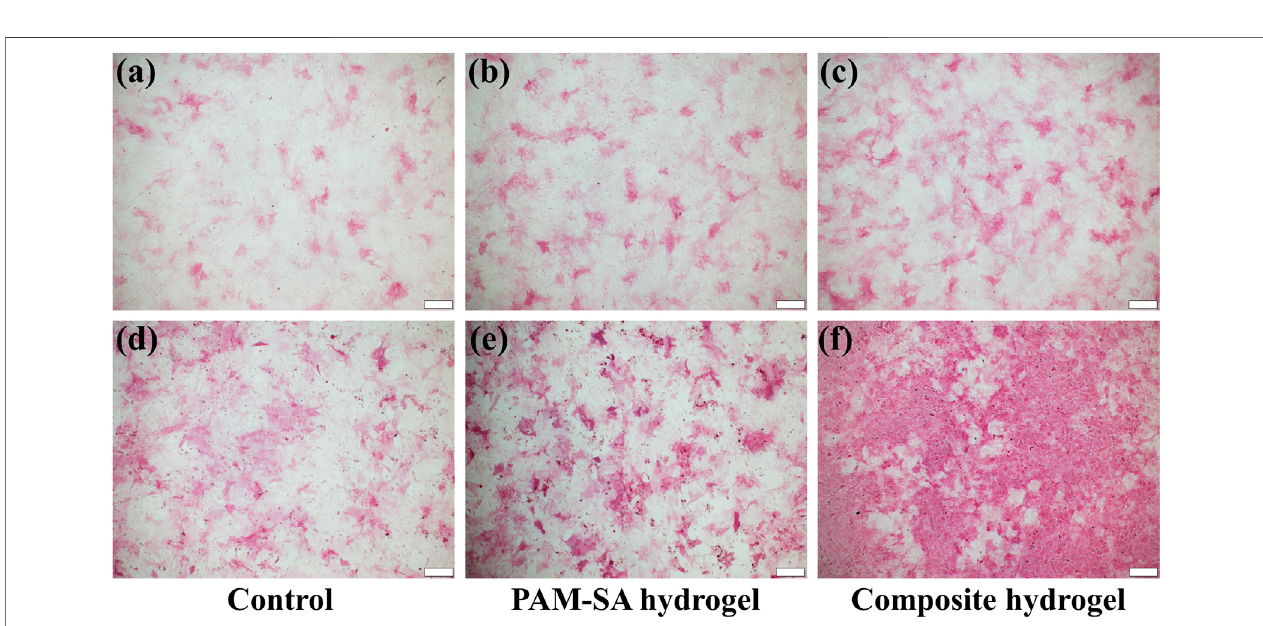
FIGURE 4 | ALP-stained photos of rBMSCs on the 7th and 14th days. (A) Control group, 7 days; (B) PAM-SA hydrogel group, 7 days; (C) Composite hydrogel group, 7 days; (D) Control group, 14 days; (E) PAM-SA hydrogel group, 14 days; (F) Composite hydrogel group, 14 days. The scale bar is 100 µm.